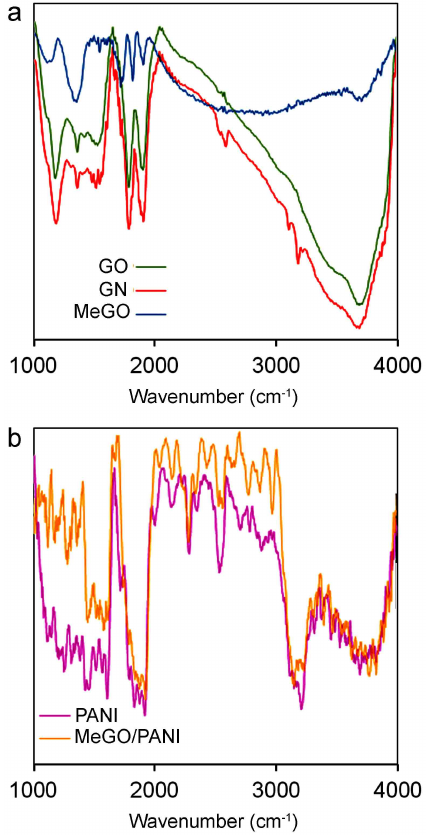
Figure 2: FT-IR spectrum of A) graphene oxide (GO), functionalized graphene with NHS/EDC (GN); MeGO and B) PANI, and MeGO/PANI